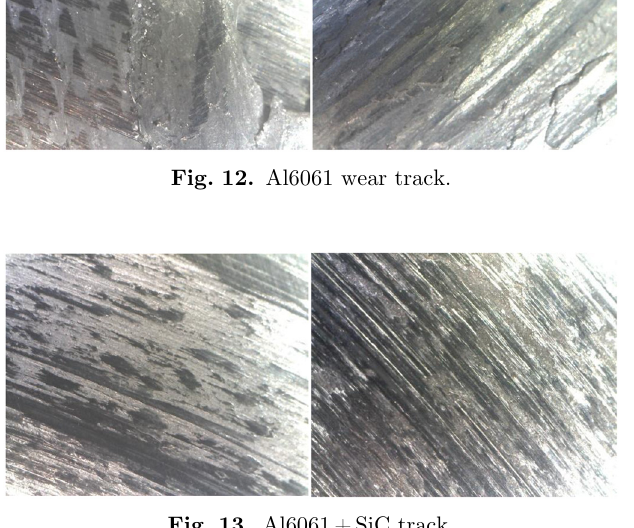
Fig. 13. Al6061+SiC